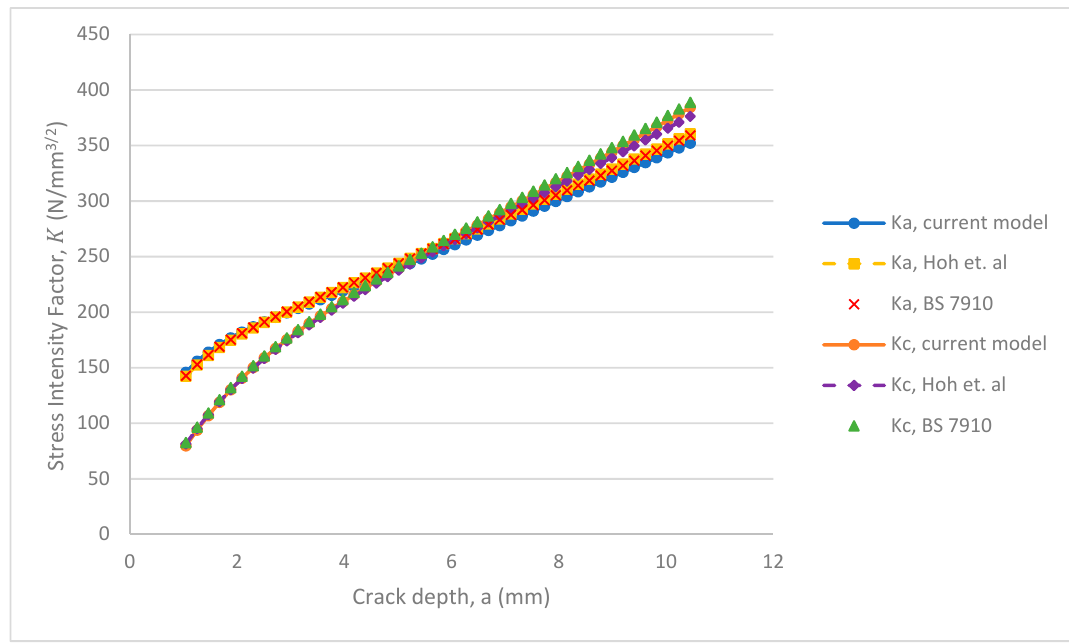
Table 5. Table of coefficients for normalized M-factor, external surface crack.